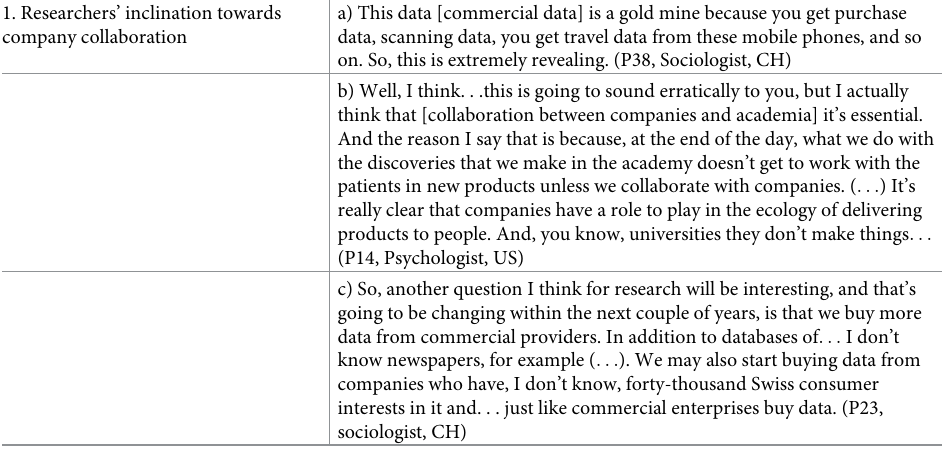
Table 6. Relevant quotes over participants’ interest in corporate